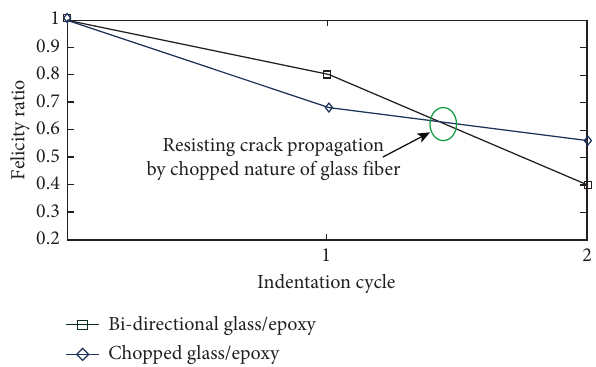
Figure 9: Measurement of damage resistance in the phase of reinforcement under cyclic